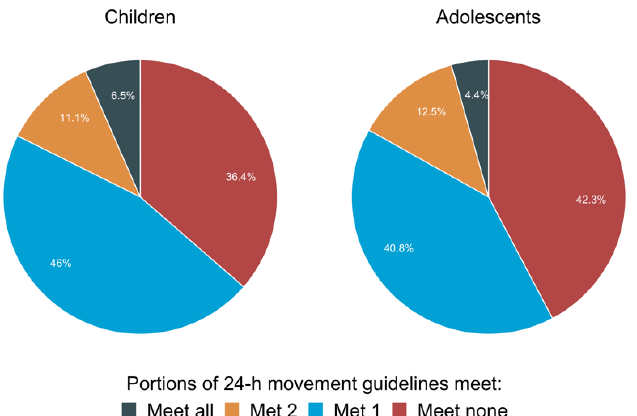
Figure 1. US National Children’s Health Survey is summarized regarding the distribution of 24 h movement guidelines (physical activity, screen time, and sleep duration recommendations) among young adults with ASD.